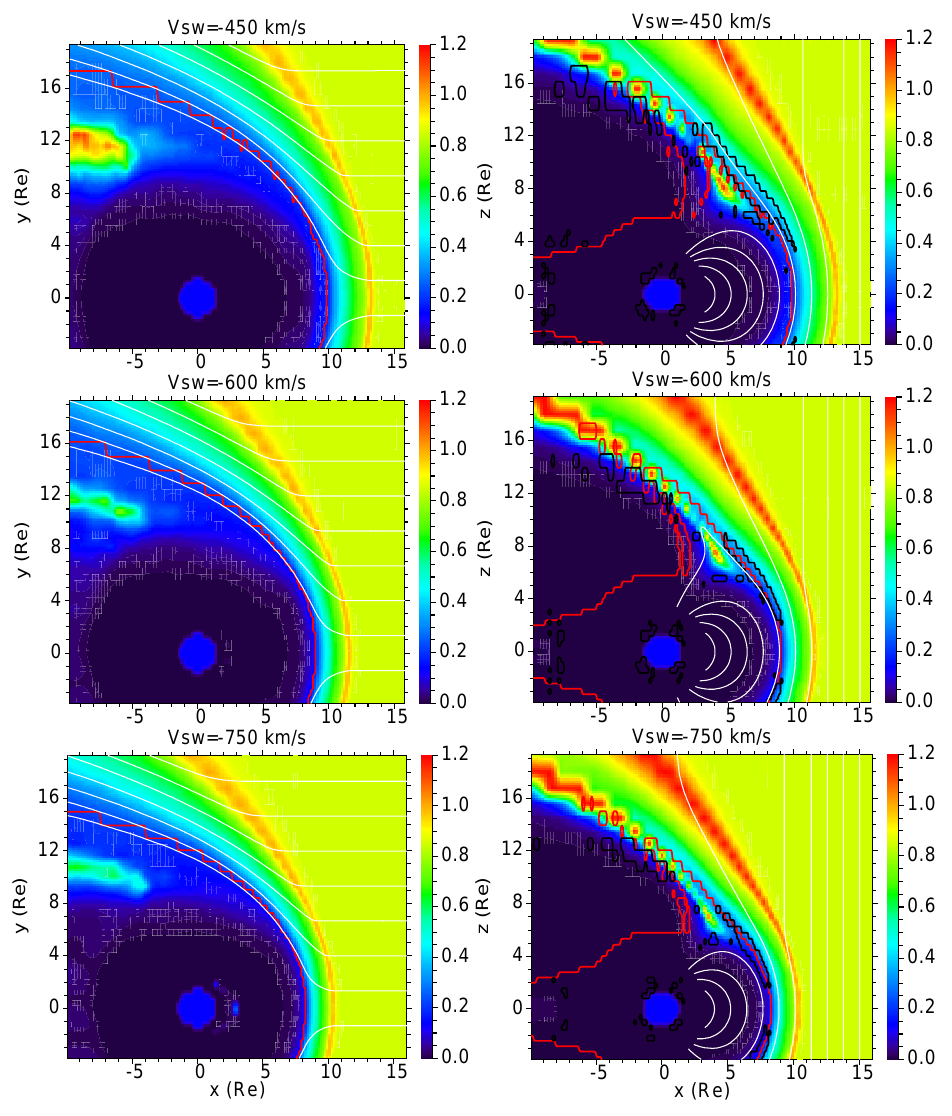
Fig. 3. The dependence of the PDL and the slow mode front on the solar wind M MS using different solar wind velocities: V x = − 450km/s (M MS =5.3), − 600km/s (M MS =7.1), and − 750km/s (M MS =8.8) as model inputs. The other solar wind input parameters are: V y = V z =0km/s, B =(0, 0, 7)nT, N=6cm − 3 , and T p =T e =10eV. The left panels show the results in the GSE z=0 plane, and the right panels show the results in the GSE y=0 plane. The N/B ratio is shown as the background and the open-closed magnetic field boundary is shown as a red zigzag curve in each of the panels. Flow lines are shown as white smooth curves in the left panels, and magnetic field lines are shown as white smooth curves in the right panels. The boundary between the regions where the slow mode group velocity can and cannot overcome the flow velocity are shown as black zigzag curves in the right panels. The slow mode fronts are the segments of these black curves where plasma flows into the closed black curve regions (Wang et al.,